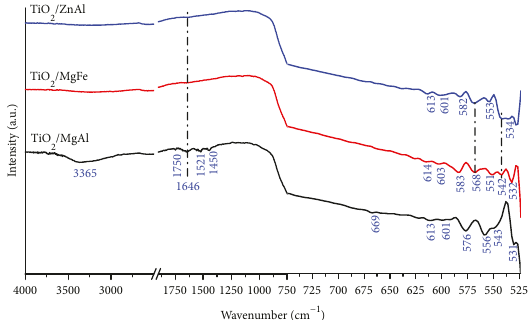
Figure 2: IR spectrum for synthesized TiO